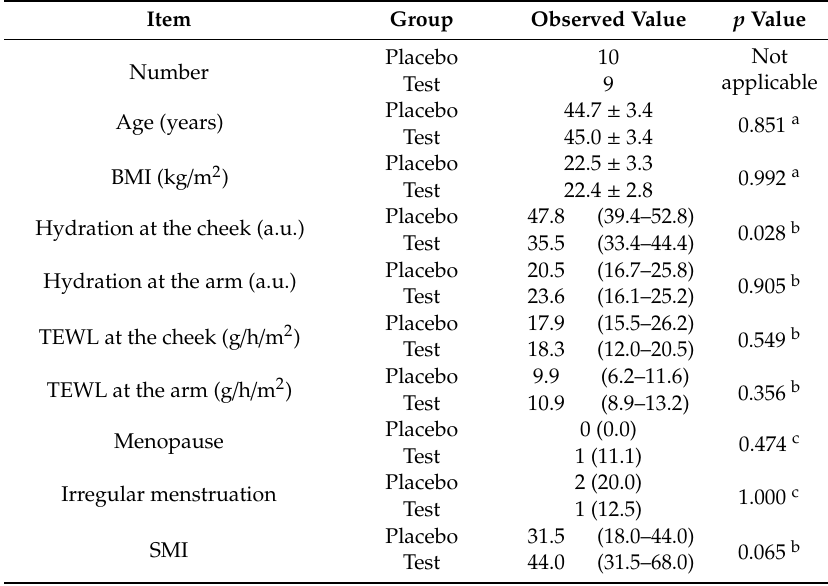
Table 2. Background characteristics of the participants.